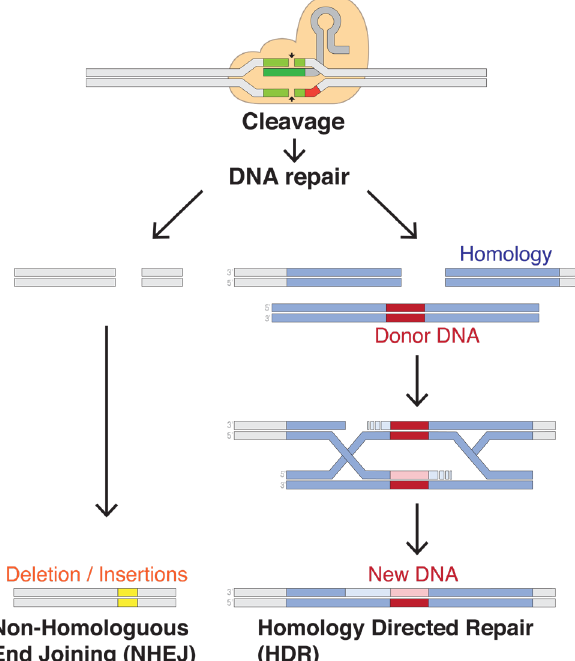
Figure 2: Two fates of double strand breaks created by CRISPR/Cas9. On the left, the break is directly re-sealed by a mechanism called “non-homologous end joining.” The sequences at the re-joined ends may differ by short additions or deletions of nucleotides from the original sequence before cleavage. On the right, the break is repaired by aligning the flanking sequences (blue) with a homologous DNA sequence, either from a homologous chromsome or from an engineered DNA containing additional DNA (red) between the homology tracts. Using the standard recombination mechanism, the break is repaired (new DNA) with possible addition of novel DNA sequence at the site of the break. Image created by